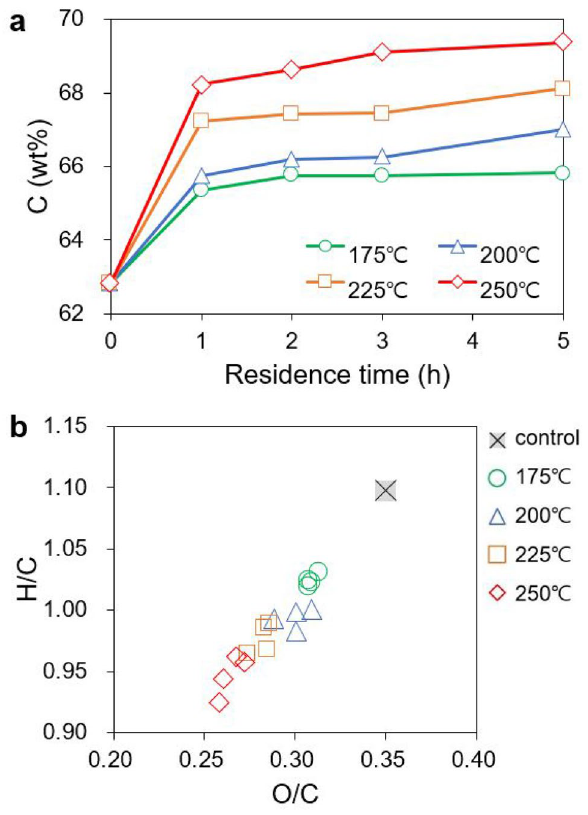
Figure 1. Carbonization characteristics of lignin-derived hydrochars. ( a ) Changes in carbon content of lignin samples with HTC temperature and residence time, and ( b ) its van Krevelen diagram, a plot of atomic O/C vs. atomic H/C.